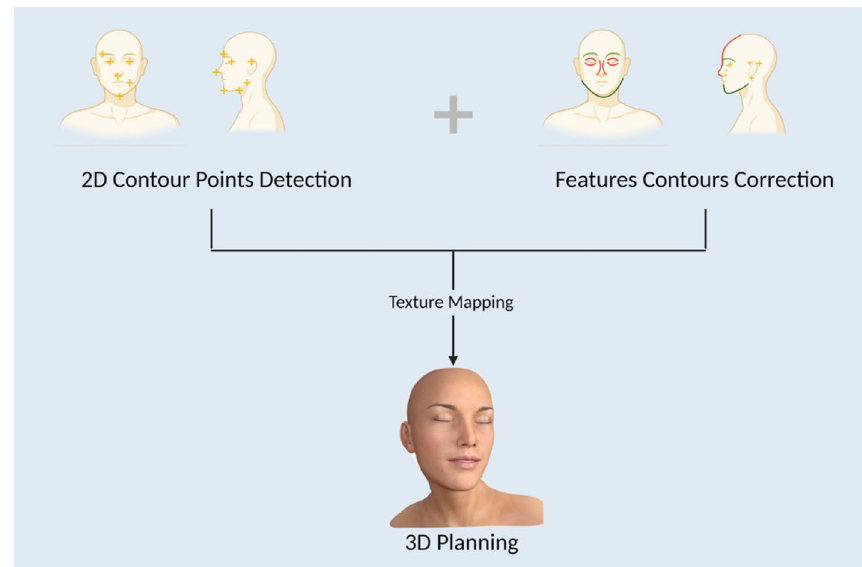
Fig. 2 Using 2D photographs to create 3D models